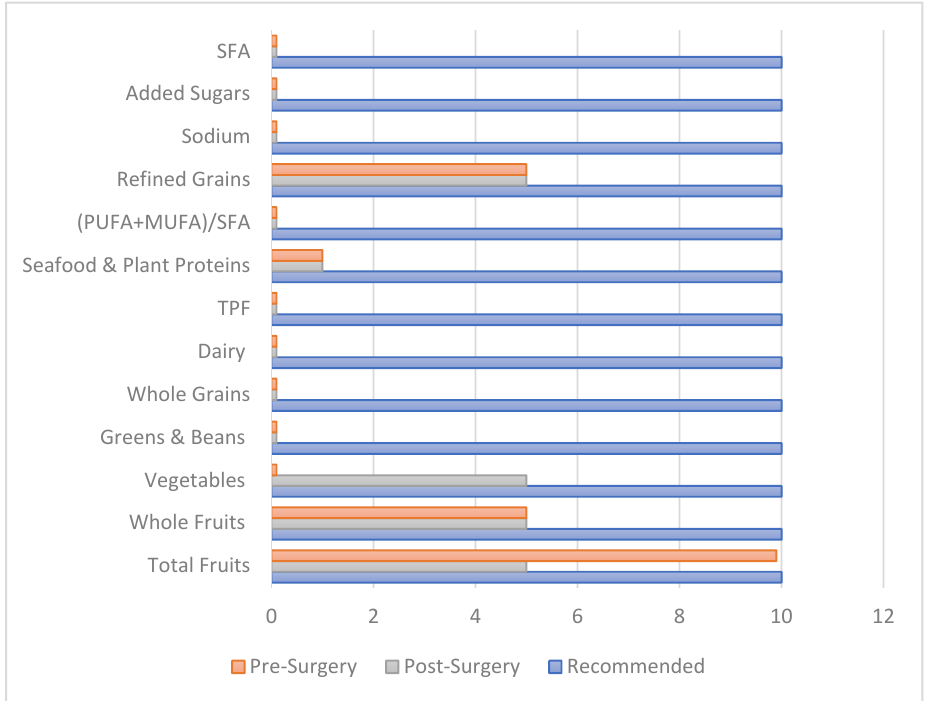
Figure 1. Bar chart of healthy eating index components in the perioperative phase compared to the relevant recommendations. TPF: total protein foods; SFA: saturated fatty acids, PUFA: polyunsaturated fatty acids; MUFA: monounsaturated fatty acids.